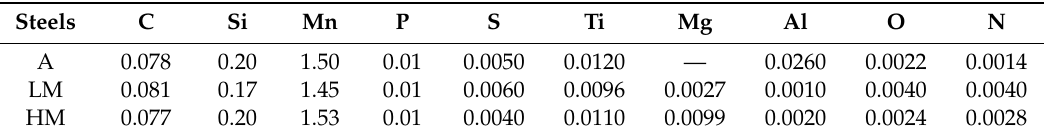
Table 1. Chemical compositions of experimental steels (wt%).